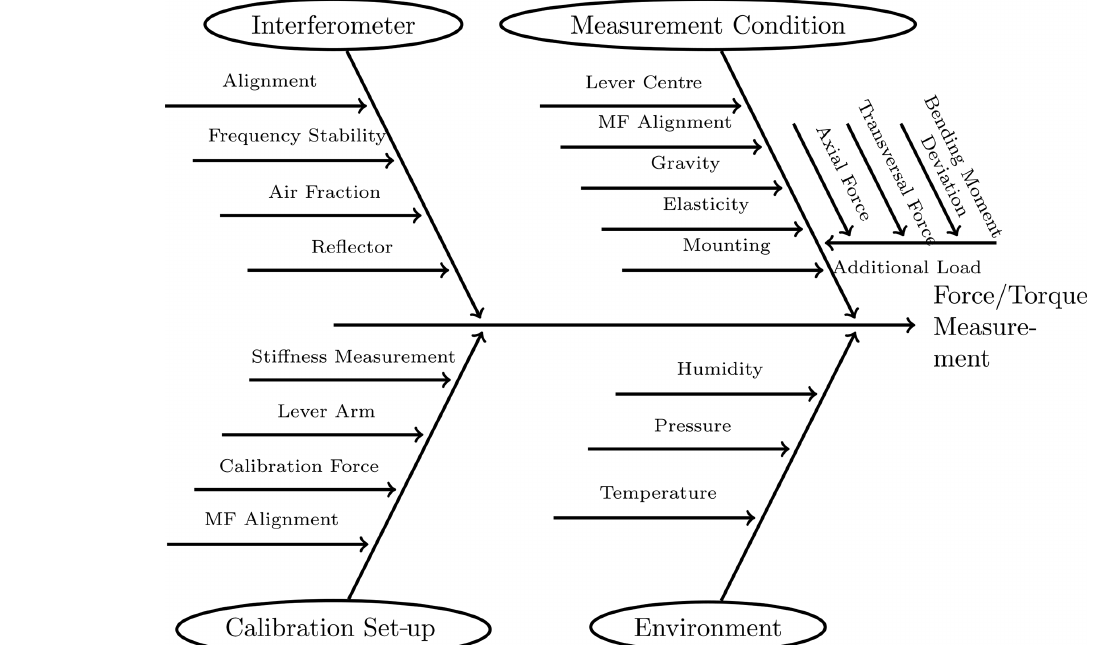
Figure 4. Measurement uncertainty influences of FT and TM measurement with MF.